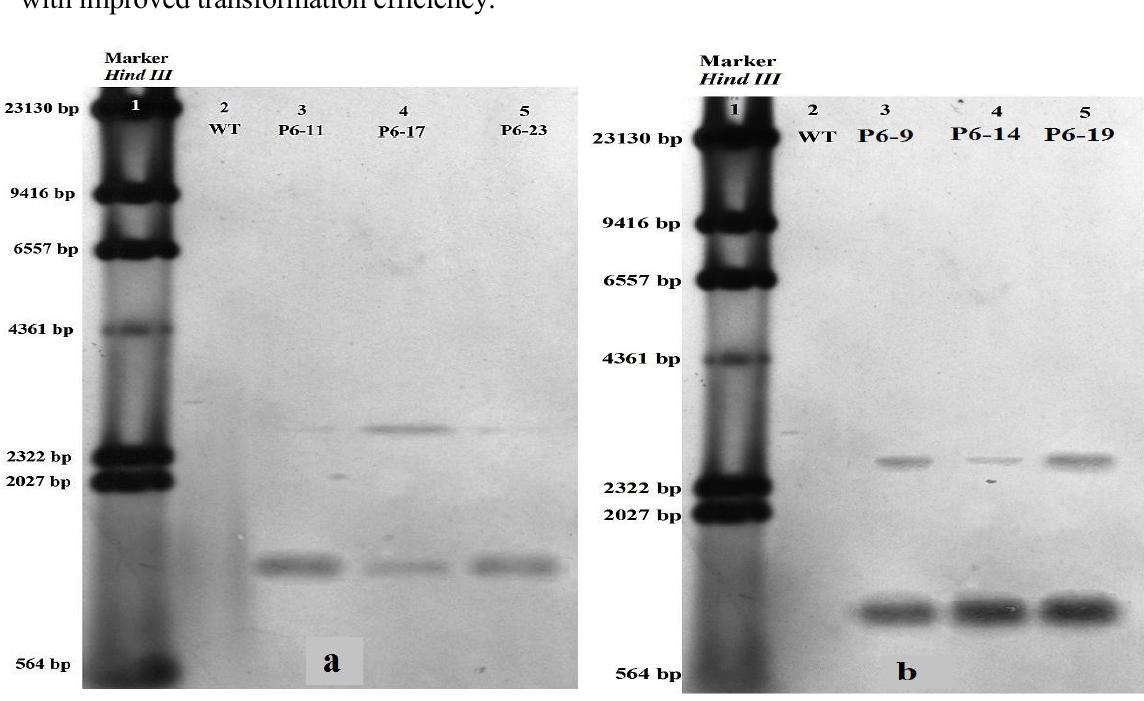
Figure 6. ( a ) Northern blot analysis of transgenic poplar lines generated without improved transformation efficiency. Total RNA (ribonucleic acid) was separated on a formaldehyde gel and blotted onto a nylon membrane after staining with ethidium bromide. A 433-bp fragment of CarNAC6 cDNA generated by PCR (polymerase chain reaction) was used as a probe. CarNAC6 gene expression (0.5–0.8-kb band) in transgenic poplar lines. Lane 1: marker (λ Hin dIII); Lane 2: wild-type (WT) poplar; Lanes 3–5: total RNA extracted from three transgenic poplar lines; ( b ) Northern blot analysis of transgenic poplar lines generated with improved transformation